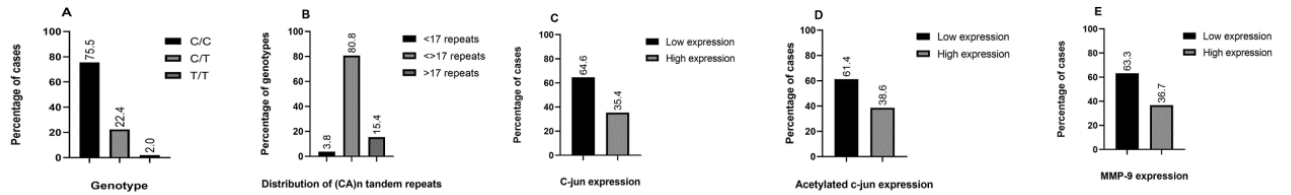
Figure 1. Distribution of -1562 C/T ( A ) and -131(CA)n ( B ) MMP-9 polymorphisms and c-Jun ( C ), acetylated c-Jun ( D ), and MMP-9 € expression patterns in PTC samples ( E ).